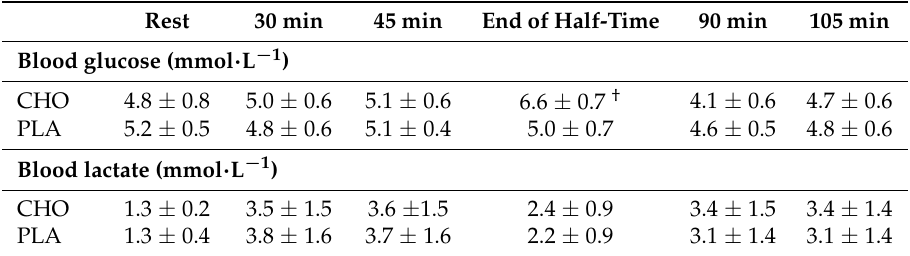
Table 2. Blood glucose and lactate concentrations (mmol · L − 1 ) during CHO and PLA trials. Rest 30 min 45 min End of Half-Time